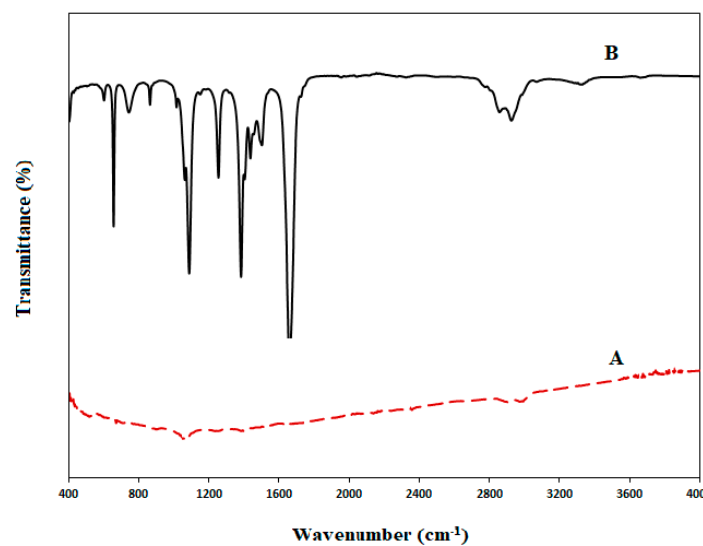
Figure 3. FTIR for A. MWCNT, B. MWCNT/PPy.